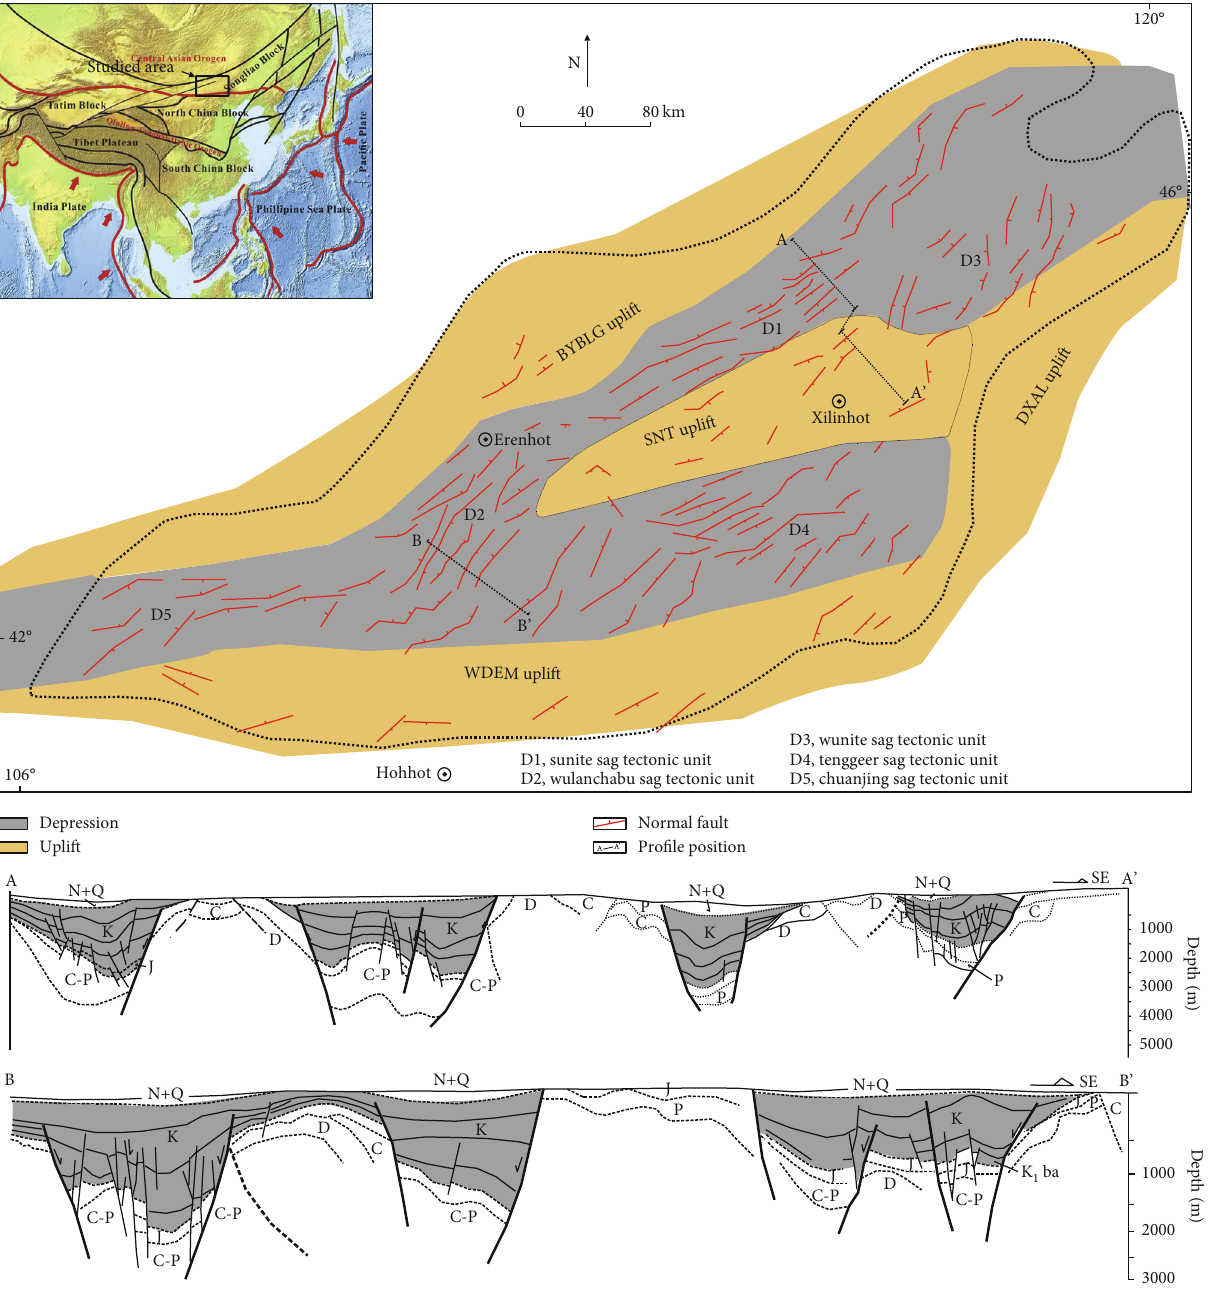
Figure 1: Distribution of tectonic units, major faults, and typical sections of faulted-sag basins in Erlian Basin interpreted from seismic data (revised after